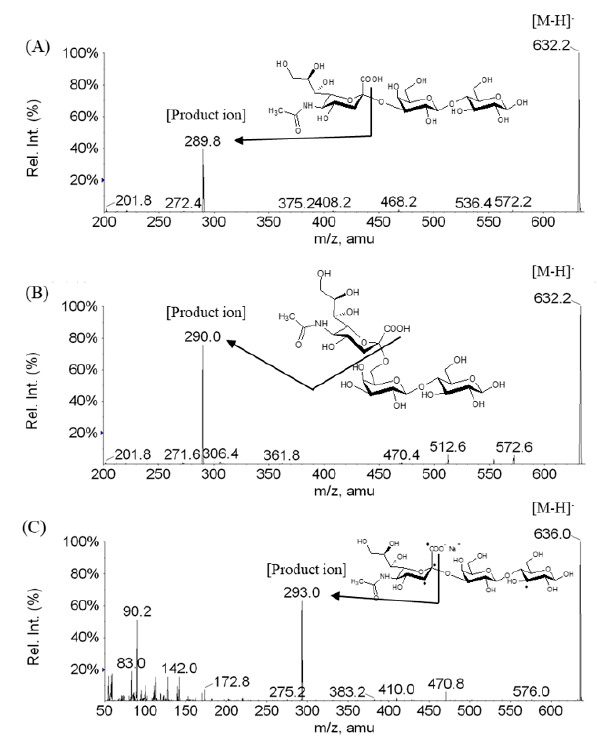
Figure 1. The chemical structure and product ion scan spectra of ( A ) 3 ′ -sialyllactose, ( B ) 6 ′ -sialyllactose, and ( C ) internal standard.